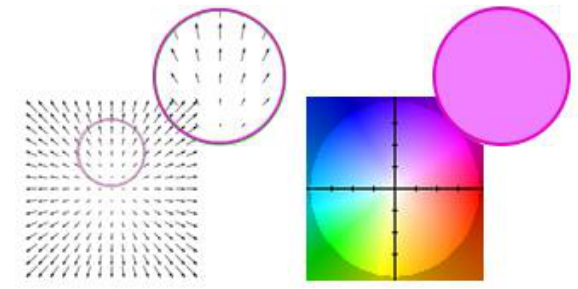
Figure 10. Color map.